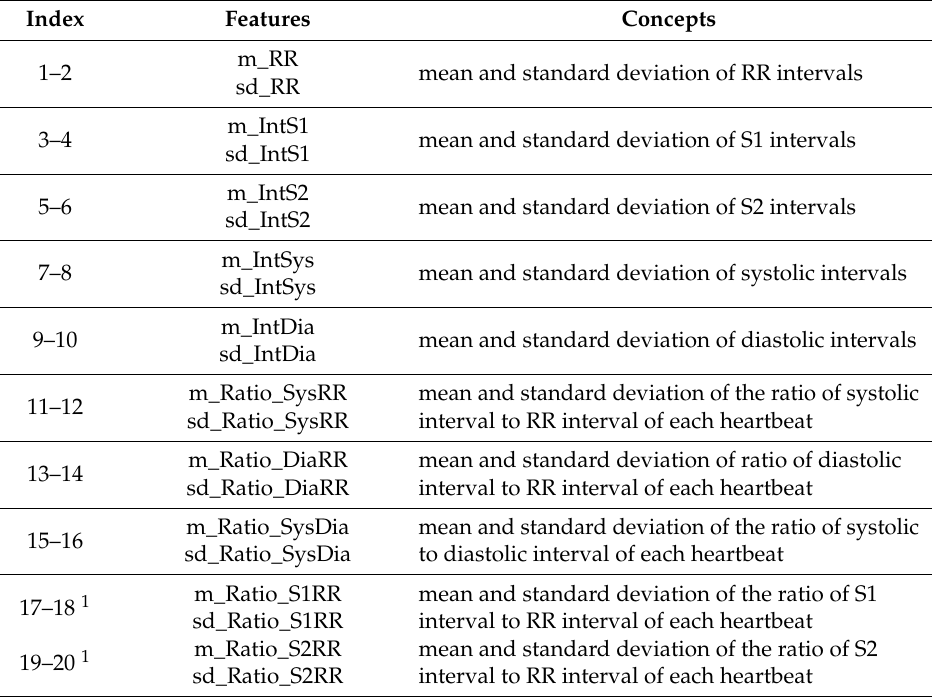
Table A1. The summary of the features extracted from time domain.